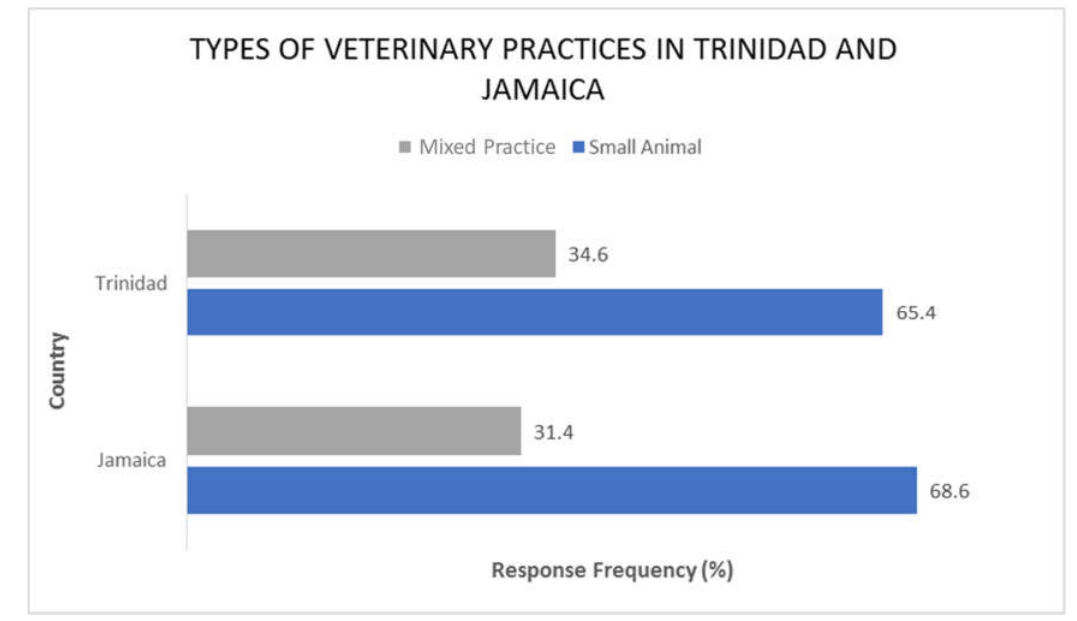
Figure 1. Showing the types of Veterinary practices in Trinidad and Jamaica. Our study indicated that, the percentage of veterinarians employing antimicrobial combination therapy is higher in Trinidad (74.3%) compared to Jamaica (57.7%), (Figure 2).